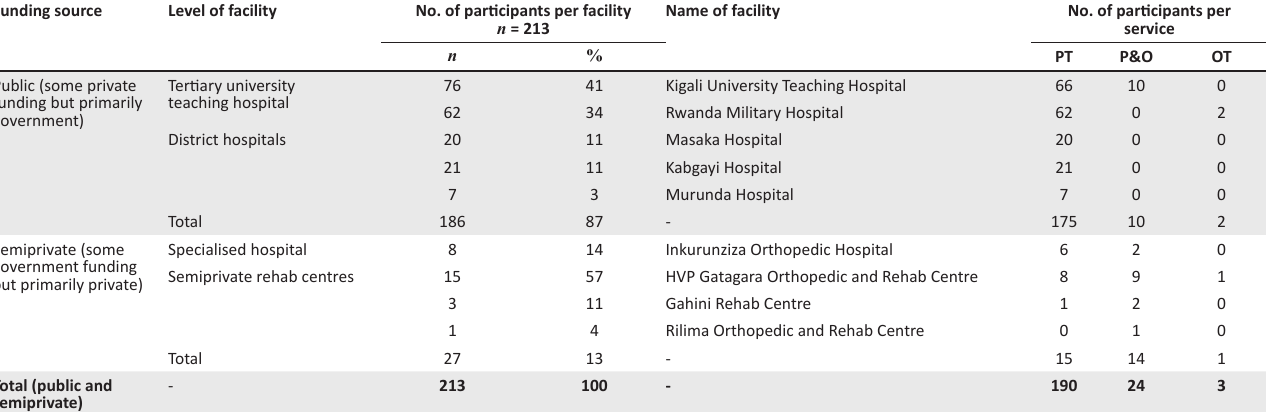
TABLE 2a: Distribution of participants, by funding source, type of health facility visited and rehabilitation services received. Funding source